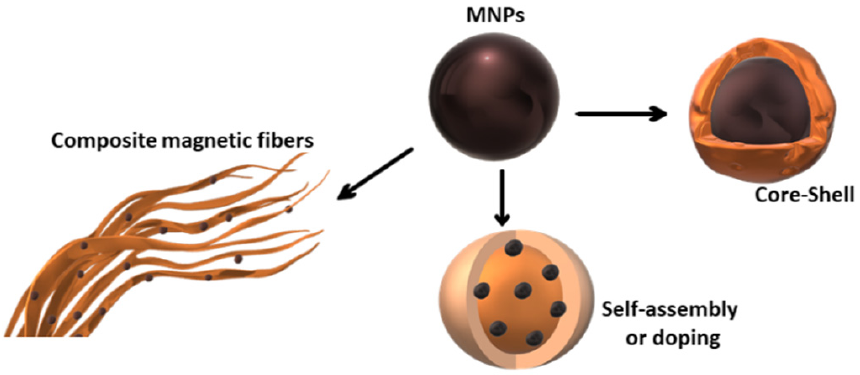
Figure 4. Primary polymer-coated MNC